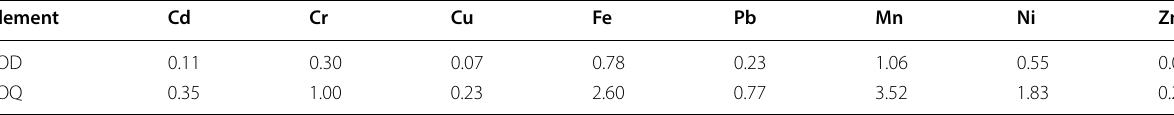
Table 1 LOD and LOQ values of elements analyzed by ICP-OES Element Cd